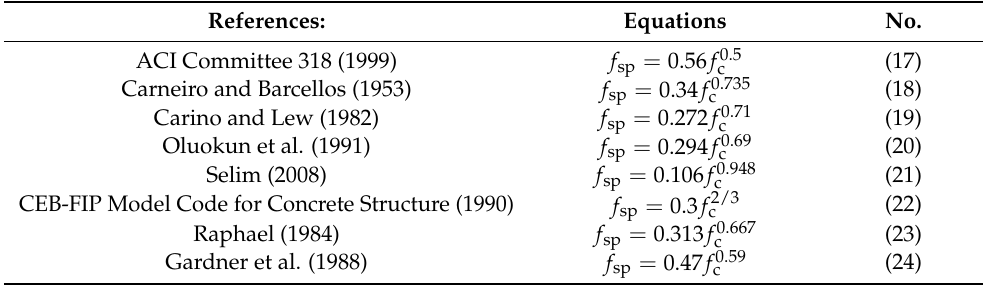
Table 5. Relationship between compressive and splitting tensile strength adapted from Chamroeun et al., 2017 [47].